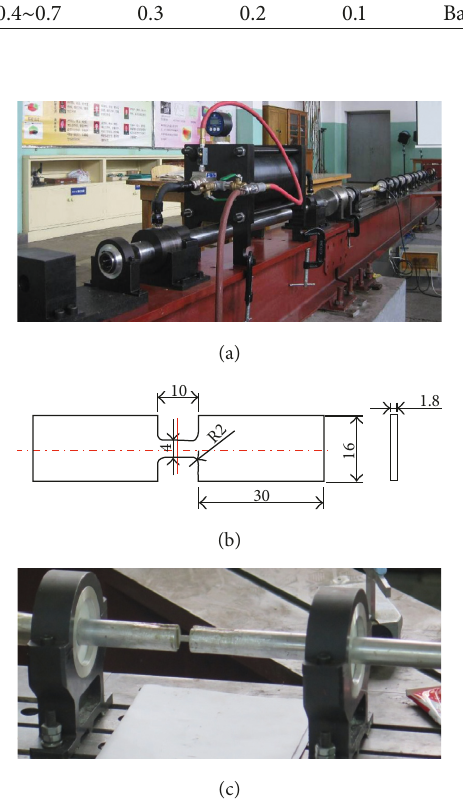
Figure 2: (a) Split-Hopkins tensile bar (SHTB) testing system; (b) specimen for the tension test under high strain rate; (c) specimen fixed in the SHTB